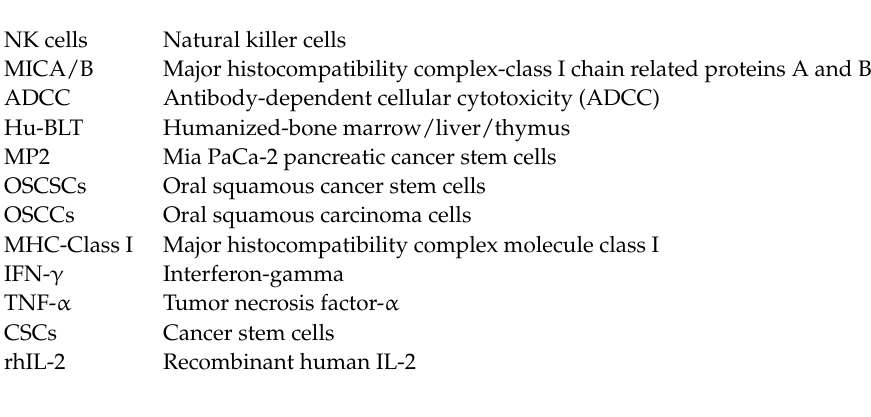
Figure S3: NK cells’ surface expression on healthy individual and cancer patients, Figure S4: Surface expression levels of CD16 on primary NK cells, OC-expanded NK cells and NK92 cell lines, and NKG2D surface expression level on primary NK and OC-expanded NK cells, Figure S5: Higher levels of NK cell-mediated ADCC was seen in freshly isolated primary NK cells vs. OC-expanded NK cells, Figure S6. Higher surface expression of EGF and B7H1, and NK cell-mediated ADCC in differentiated tumors in comparison to their stem-like